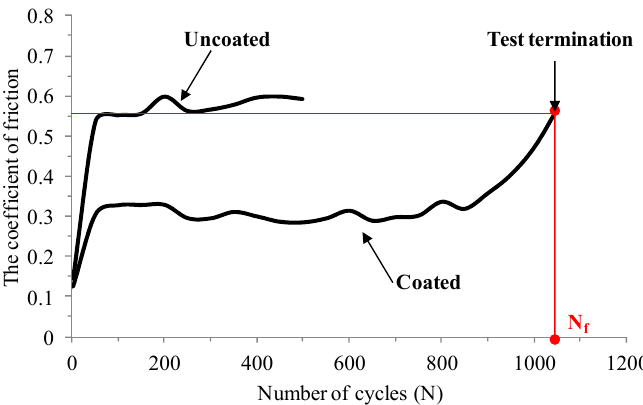
Figure 4. Test termination of a fretting test with a coated system. N f can be defined as the durability of a coated system.